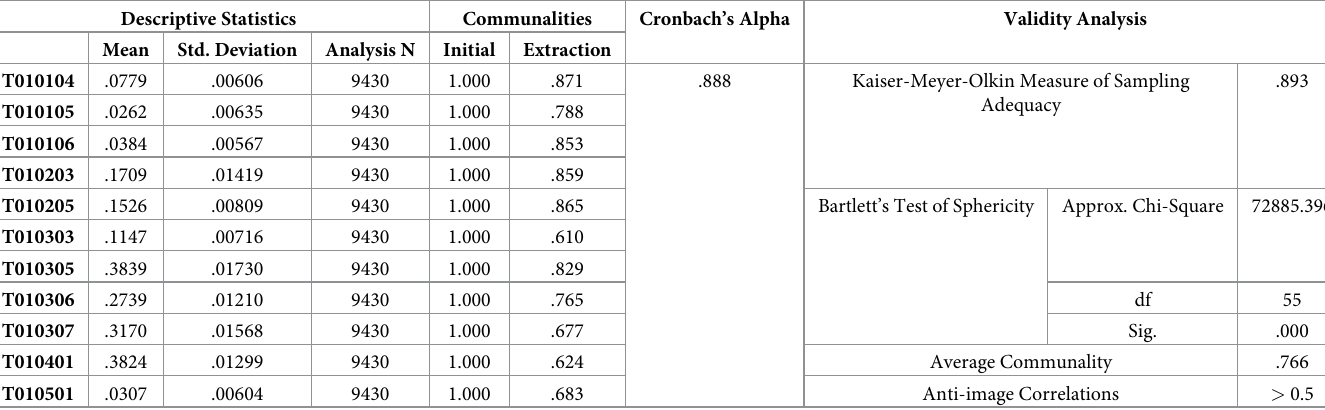
Table 8. Repeated reliability and validity analysis of gas data in Case Study